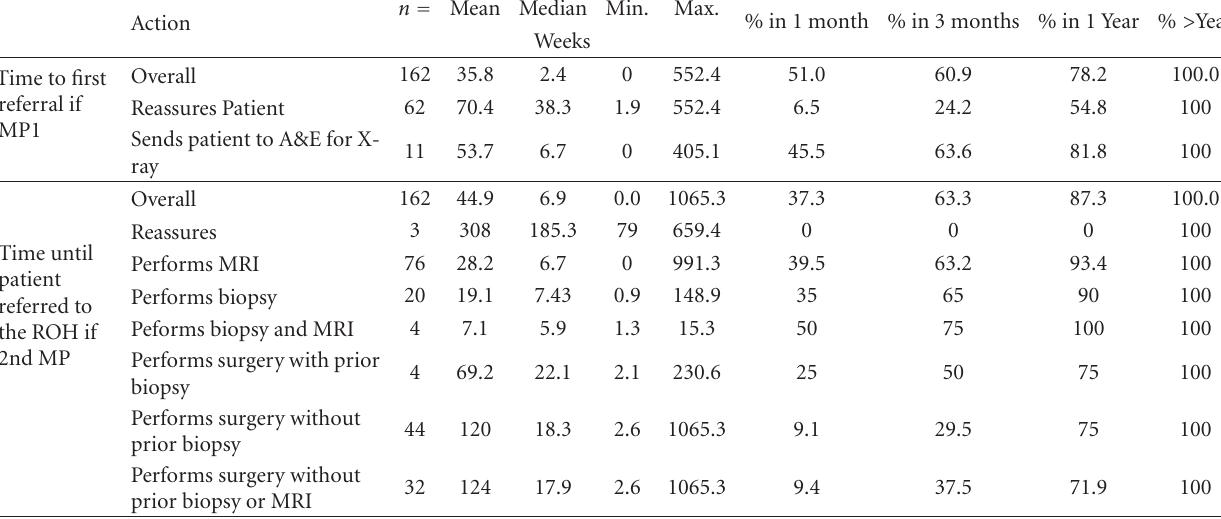
Table 4: Medical professional delay